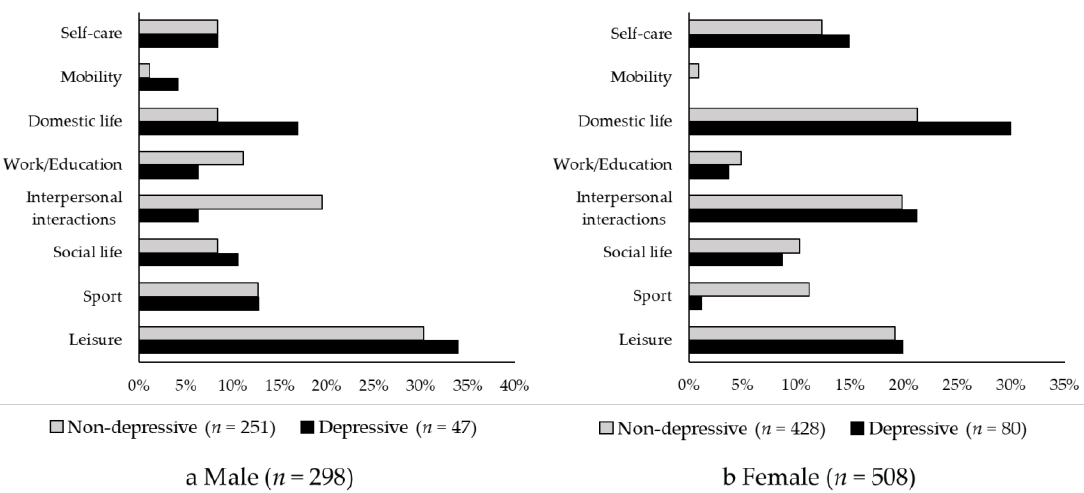
Figure 3. Proportions of meaningful activity categories for non-depressive and depressive groups by gender. ( a ) Proportions of each meaningful activity category in men. ( b ) Proportions of each meaningful activity category in women. There were no significant di ff erences in the proportions of meaningful activity categories depending on the presence or absence of depressive symptoms, in both men ( p = 0.120) and women ( p = 0.088).